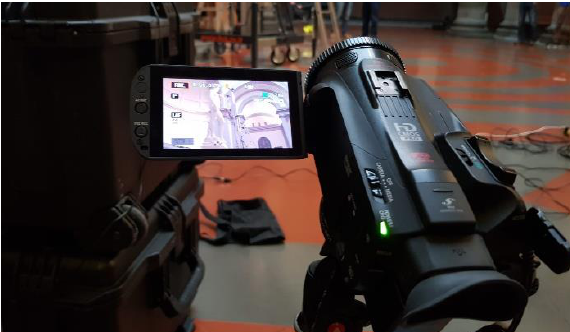
Figure 2: Canon Legria HF G30 camera, deployed to perform 60fps images acquisition for monitoring gantry stability and